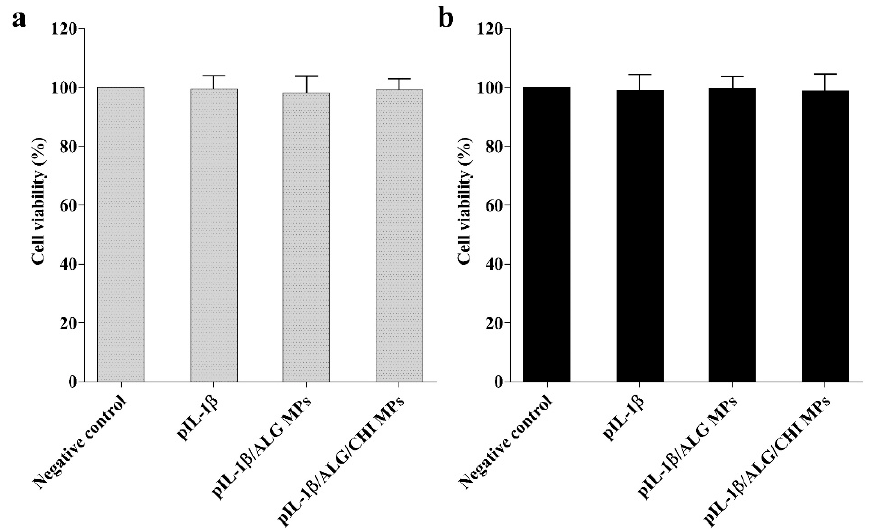
Figure 6. Cytotoxicity of pIL-1 β , pIL-1 β /ALG MPs, and pIL-1 β /ALG/CHI MPs upon incubation with ST cells ( a ) or PK-15 cells ( b ). Negative controls included untreated ST cells and PK-15 cells.